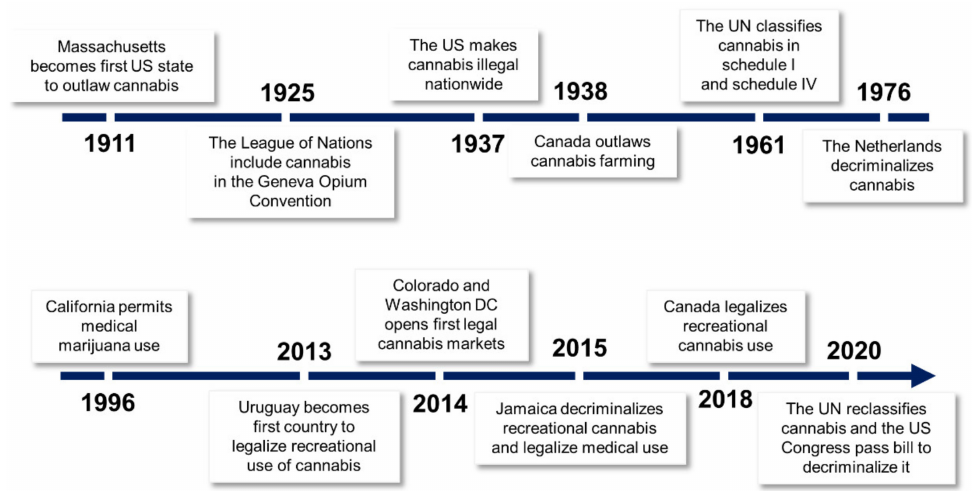
Figure 5. Major events in the legal history of Cannabis. The first six decades of the 20th century encompassed the enactment of strict laws to regulate Cannabis use. Soon after, the relaxation of regulations started with The Netherlands’ decriminalization of Cannabis in 1976. The first country to legalize recreational use of Cannabis was Uruguay in 2013, followed by Canada five years later. In 2020, the United Nations (UN) reclassified Cannabis by removing it from its most strict schedule of narcotic drugs.